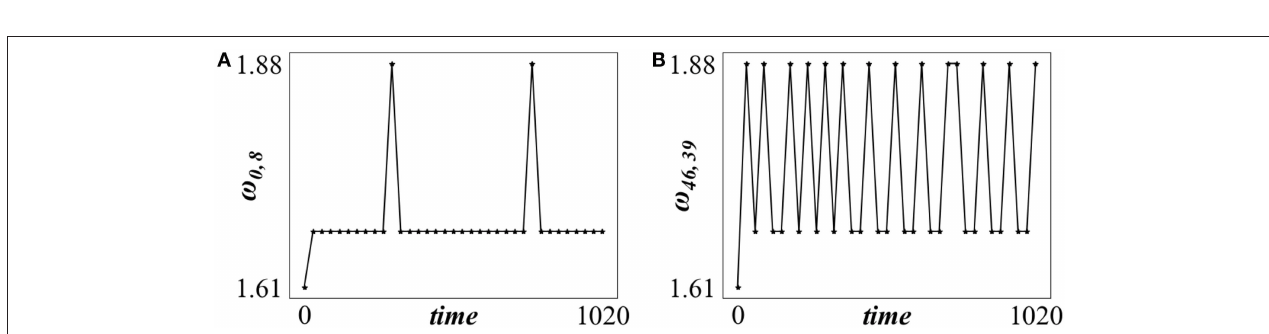
FIGURE 3 | The time evolution of ω for (A) element ( i , j ) = (0,8) belonging to the coherent domain and (B) element ( i , j ) = (46,39) belonging to the incoherent domain of Figure 2 . σ = 0.18 and T r = 0. Parameters are as in Figure 2A